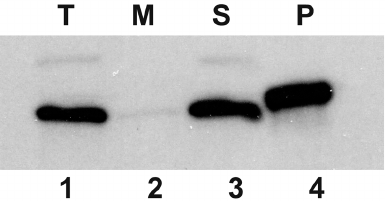
Figure 2. HepA is a cytoplasmic protein. Western blot with an anti-HepA antiserum on whole cells